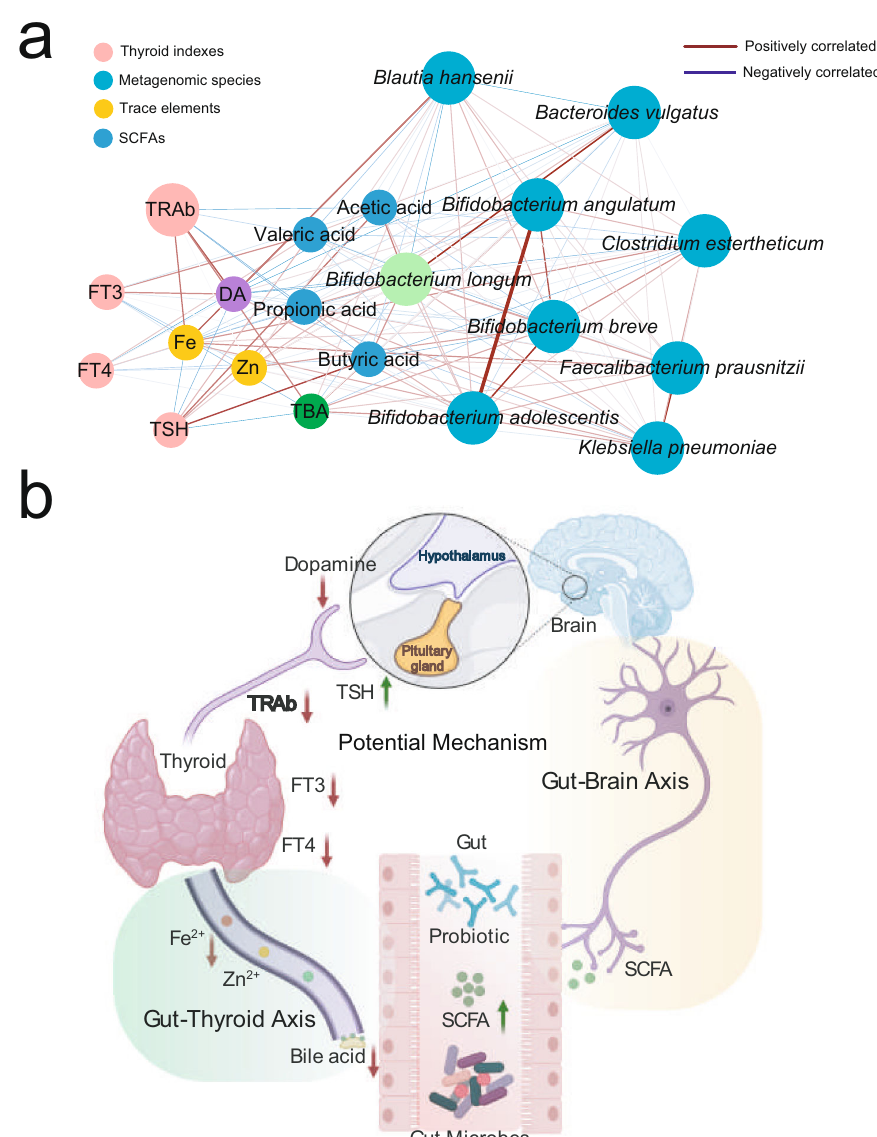
Fig. 8 The potential mechanism underlying the interaction between probiotics and thyroid clinical indexes. a The network including probiotic Bi fi dobacterium longum , probiotic closely related metagenomic species, SCFAs, dopamine, bile acid, bloody trace elements, and thyroid functional indexes based on the determined Spearman ’ s rank correlation coef fi cients. The edge widths and colors (red: positive correlated and blue: negative correlated) are proportional to the correlation strength of co-occurrence probability. The node sizes are proportional to the mean abundance in the respective population. b The simpli fi ed diagrammatic drawing, including the gut-brain axis and gut-thyroid axis to visualize the potential effective